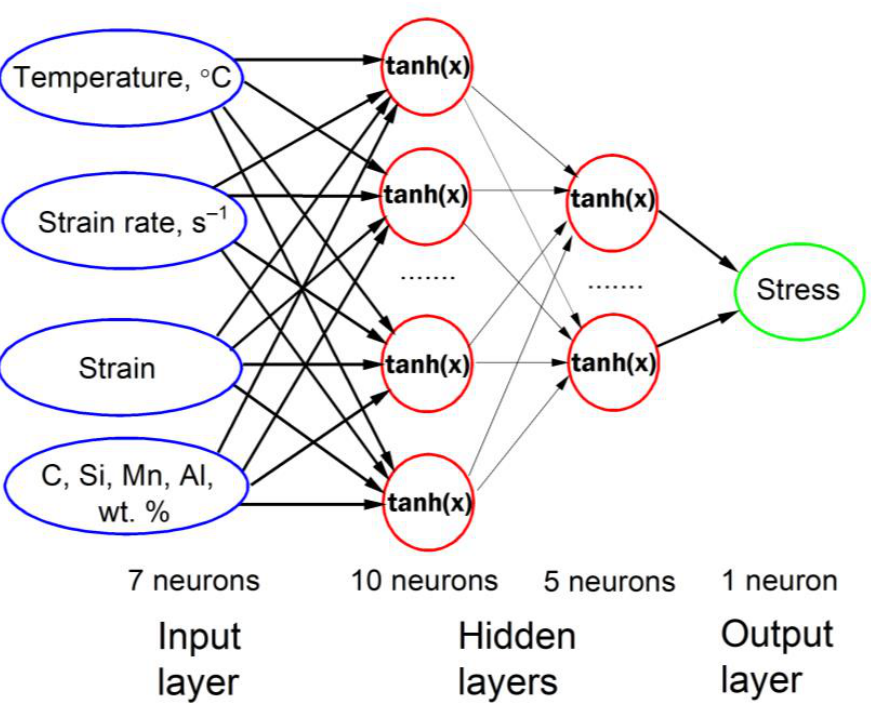
Figure 1. The ANN model organization structure.